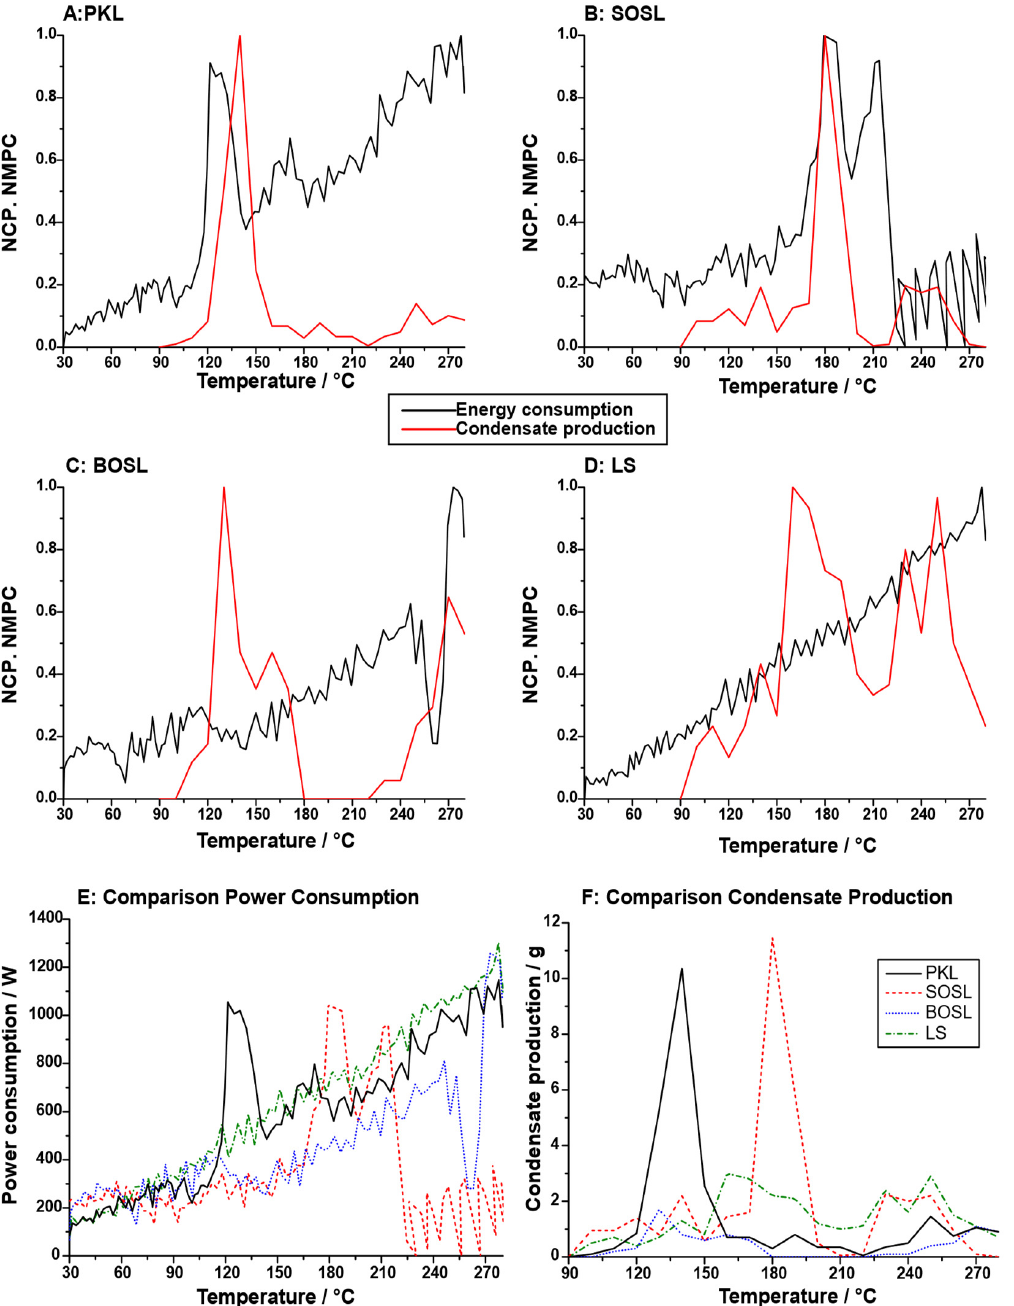
Figure 7. Normalized condensate production (NCP; red) and normalized microwave power consumption (NMPC; black) of the ( A ) PKL, ( B ) SOSL, ( C ) BOSL, and ( D ) LS as well as ( E ) a comparison of the microwave power consumption/W and of ( F ) the condensate production/g for the PKL (black; full line), SOSL (red; dashes), BOSL (blue; dots), and LS (green; dashes–dots).